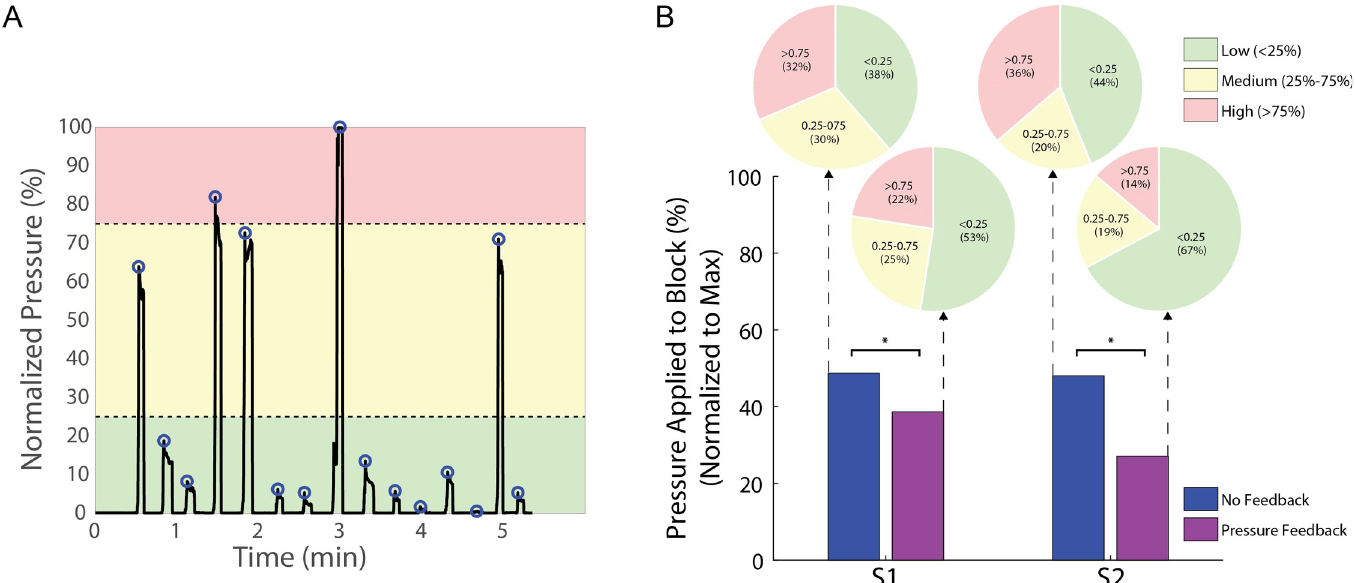
Fig 5. Amount of pressure applied during experiments. A) An example of raw pressure data acquired during a trial. In this trial, the peak pressure for the day was observed during the 8th object presentation around 3 minutes and, thus, normalized to 100%. Colored regions demonstrate how peaks were categorized as “low” (green), “medium” (yellow), or “high” (red) pressure. B) Pie charts: The percentage of normalized applied pressures when binned as low ( < 25% of the maximum applied pressure), medium (25%-75%) or high ( > 75%). Bar plots: The average normalized pressure applied over all trials. Both subjects were more likely to apply lower pressure and equally less likely to apply higher pressure when feedback was provided. There was little change in the likelihood of applying moderate pressure. This suggests an overall shift toward application of lower pressure when handling the